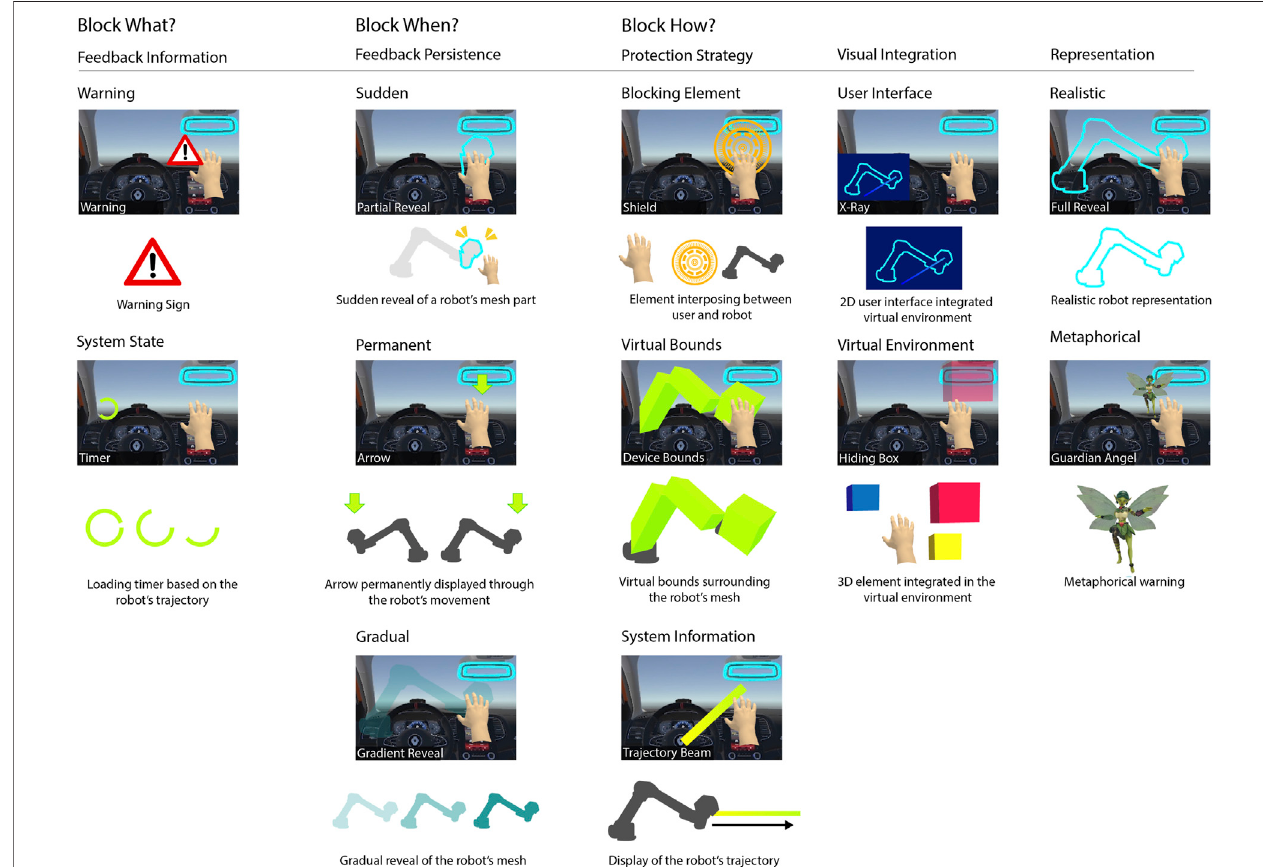
FIGURE 1 | Examples of the design space features. This fi gure illustrates the features of the design space by showcasing the visual feedback used in the implemented in some of the safety techniques.